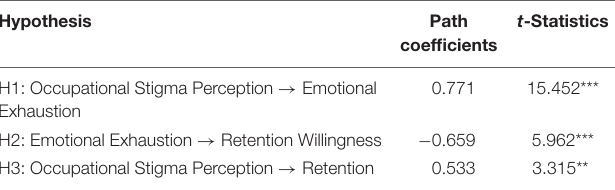
TABLE 7 | Path coefficients analysis.